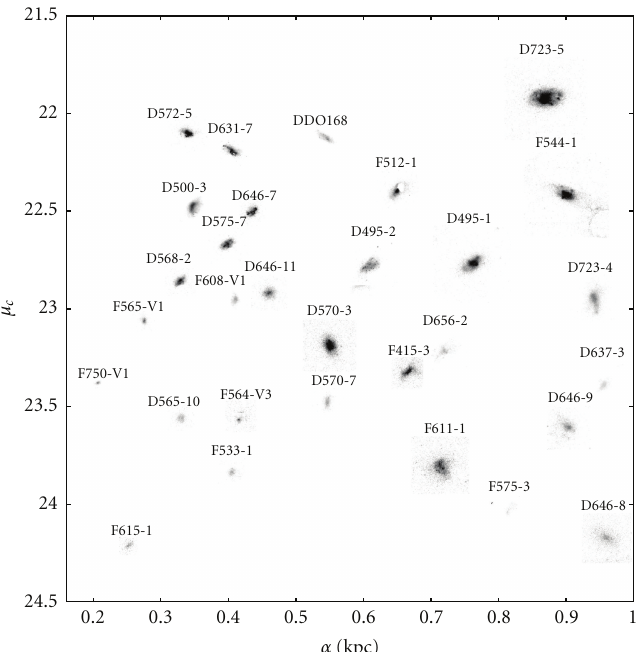
Figure 5: Galaxy morphology as a function of central surface brightness ( μ c ) and scalelength ( α ). This panel displays galaxies with scalelengths less than 1kpc. Irregular morphology dominates LSB galaxies, although smooth morphology is the signature of a gas-poor LSB and, therefore, would not be included in our sample due to a lack of an HI redshift. A larger version of this figure is available at our website.